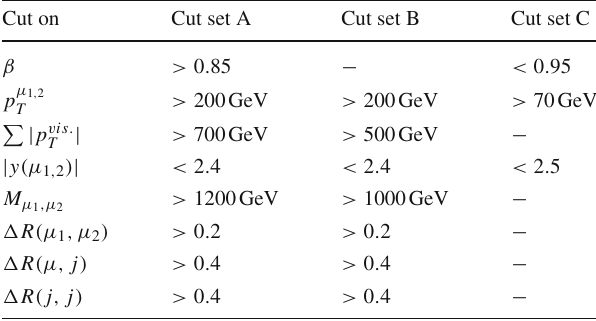
Table 6 Three sets of selection cuts applied in the ˜ τ pair